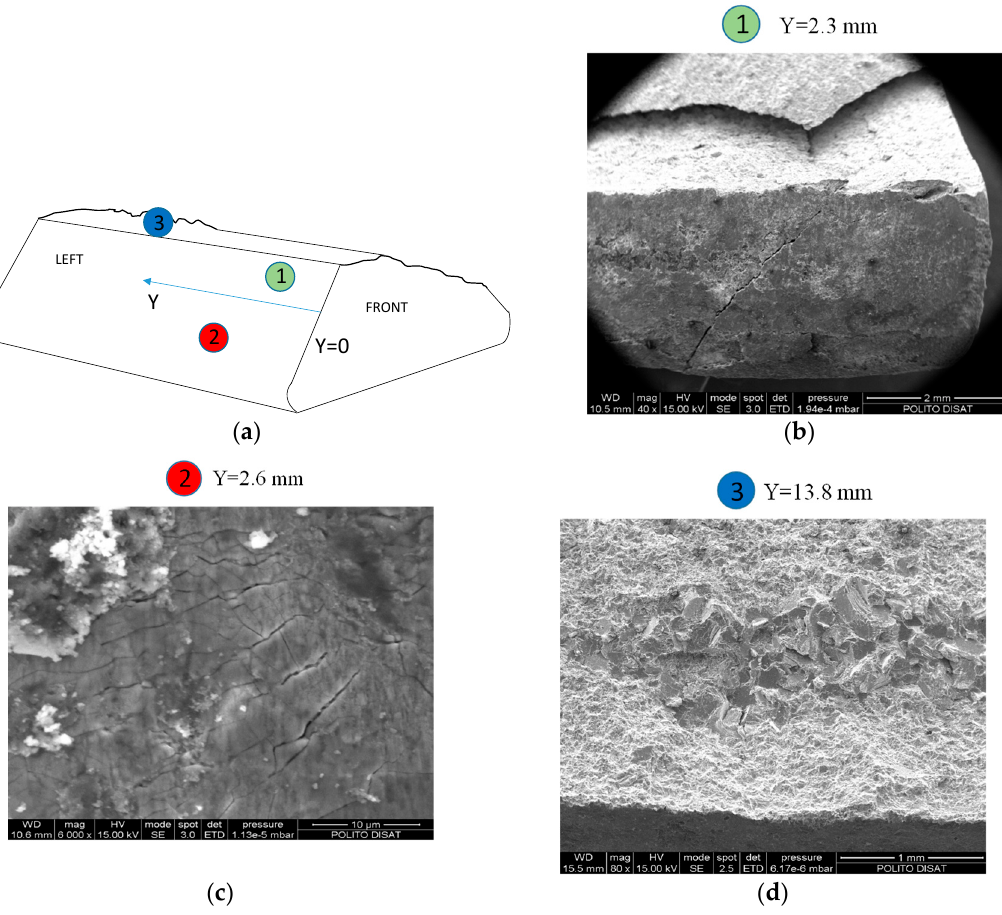
Figure 7. Scanning electron microscope (SEM) micrographs of test # 2, Y indicate the distance from the front surface: ( a ) position of SEM micrographs; ( b , c ) contact left surface; ( d ) fracture surface.